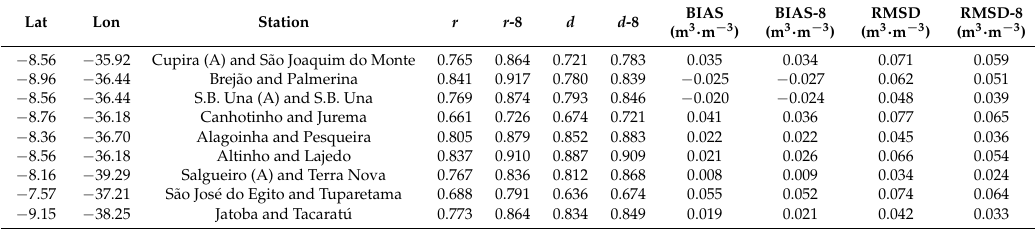
Table 1. Correlation in pixels with two stations. The letter “A” indicates an APAC station.